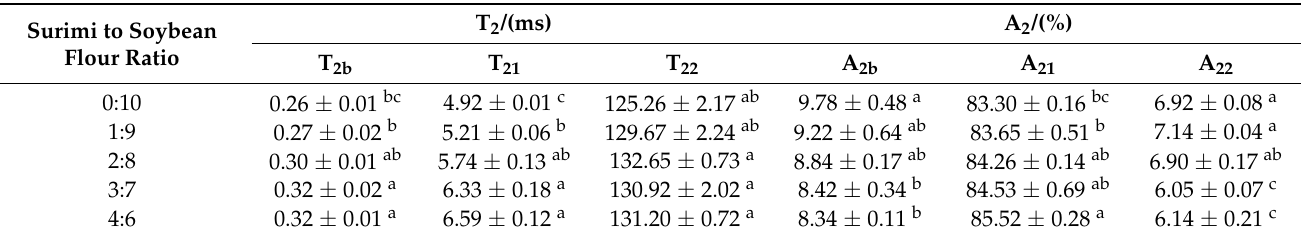
Table 2. Relaxation times and corresponding peak areas of extrudates with different surimi to soybean flour